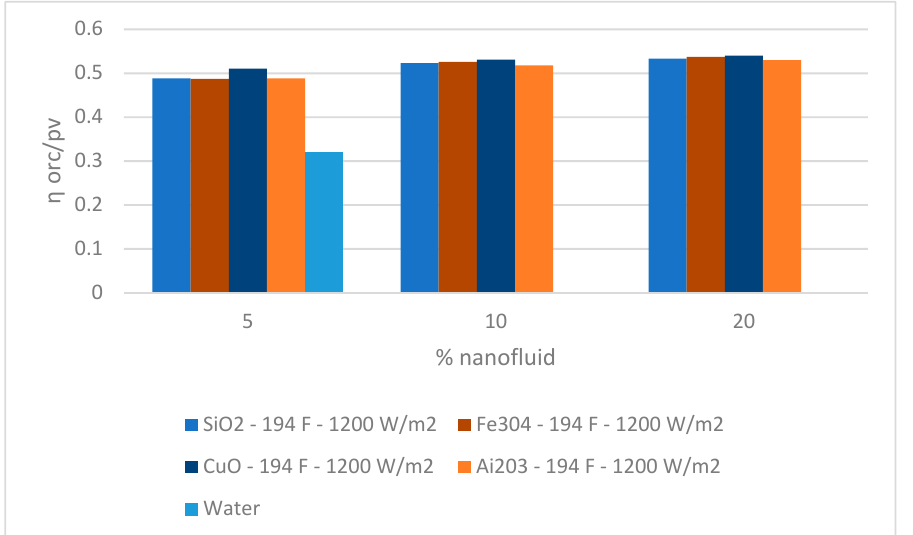
ffi ciency for di ff erent nanofluids at 194 ◦ F. Appl. Syst. Innov. 2020 , 3 , 12